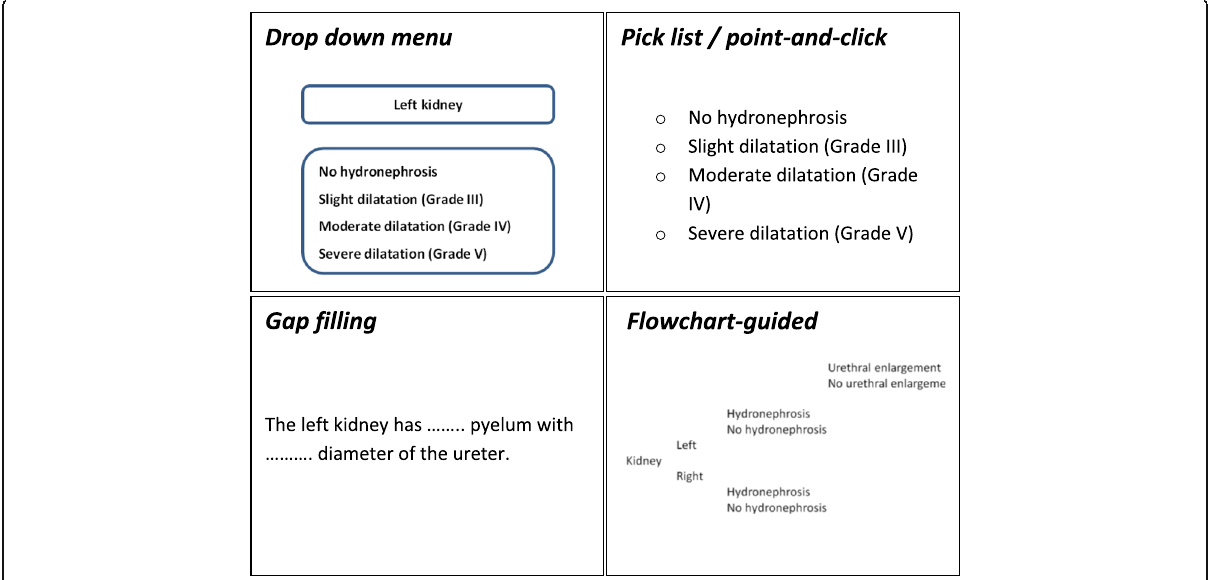
Fig. 2 Structured reporting level 2: Structured content. Examples of structured content. In a dropdown menu, the reporter chooses from several options in a different fashion than in a pick list or point-and-click system. Gap filling allows the reporter to fill in the blanks, whereas in a flowchart-guided report options are followed by a certain input made earlier in the reporting